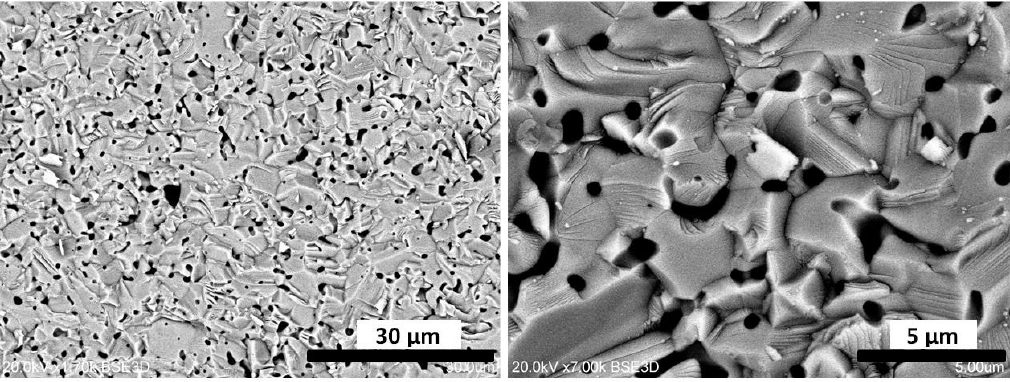
O , Pr O and HfO , at 1700 °C. Comparison with the image 2 3 4 11 2